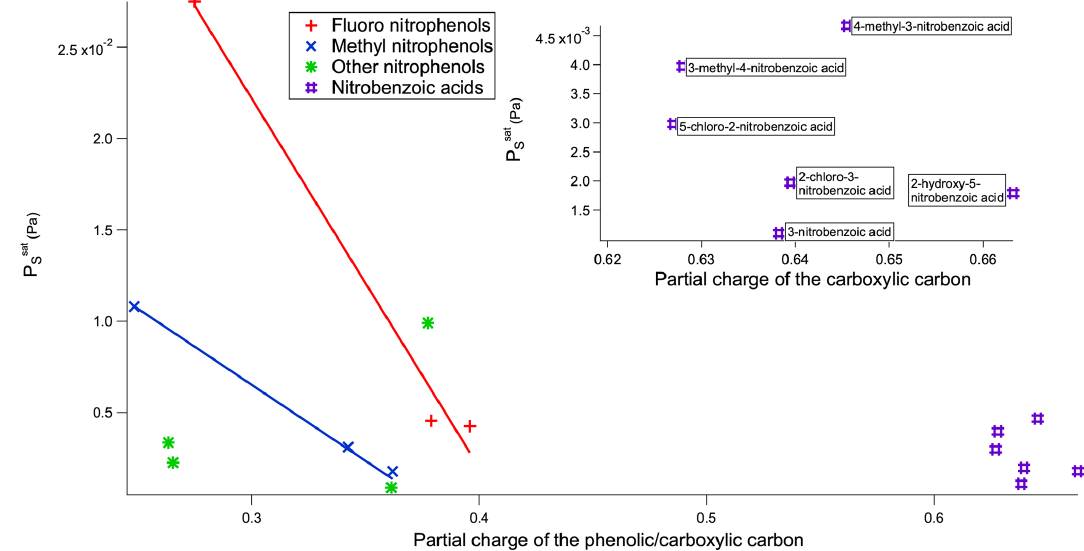
Figure 8. P sat vs. partial charge of the phenolic/carboxylic carbon of the nitrophenols and nitrobenzoic acids. S